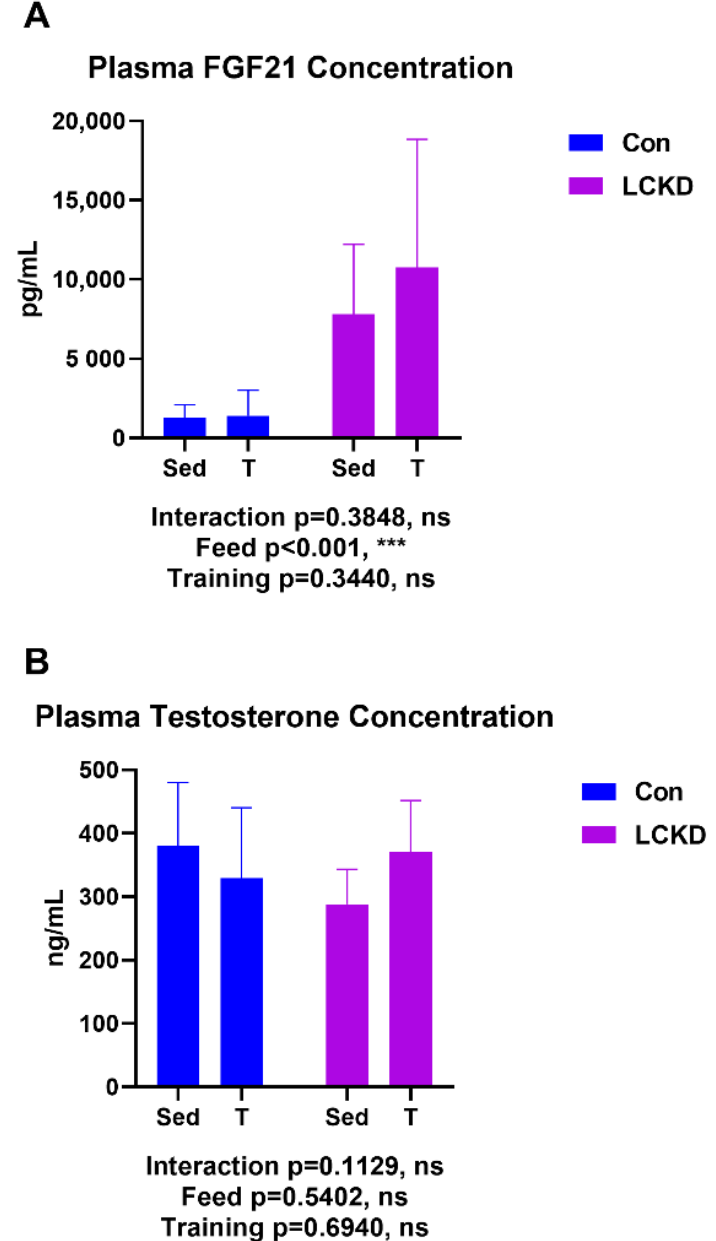
Figure 5. Plasma FGF21 and testosterone concentration. ( A ) Plasma FGF21 concentration; ( B ) Plasma testosterone concentration. FGF21, fibroblast growth factor 21; ns, no significance observed. Con, Con + T, LCKD, and LCKD + T stand for chow diet, chow diet plus training,